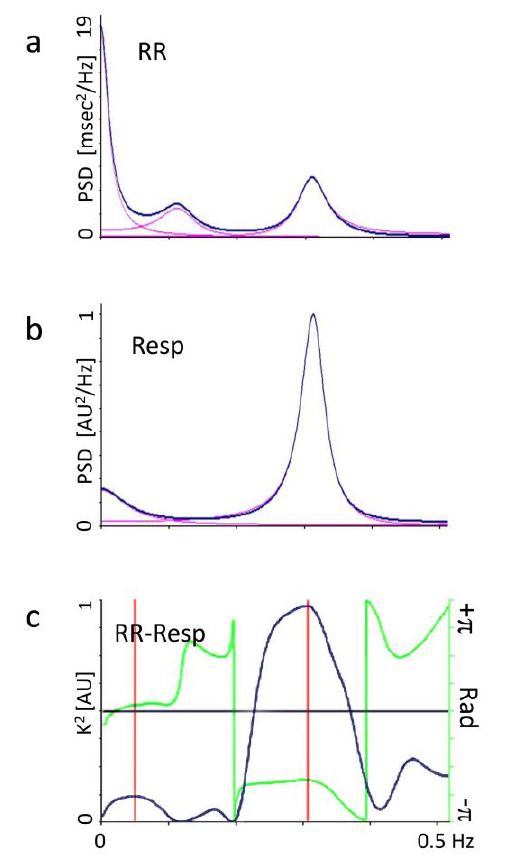
Figure 1. Panel a (labelled RR) depicts an example of an autospecrum (PSD) of RR interval variability obtained at rest on a study participant. The overall spectrum is drawn in blue, and as customary in healthy normal subjects, three major components are observed. They correspond to three individual spectral oscillations (indicated in red), that are recognized by the software tool. In normal conditions there is a component synchronous with respiration (denominated High Frequency, HF, about 0.25 Hz) and a second component at a Lower Frequency (LF, about 0.10 Hz). A third component around 0Hz corresponds to DC noise and very low frequency shifts of the RR interval signal (denominated usually VLF). Smaller noise components may also be present, usually below 5% of oscillatory power. Notice that ordinates should be multiplied by 1000. Panel b (labelled Resp) depicts an example of respiratory autospectrum. Notice that a single major component (at high, respiratory frequency) is observed typical of resting, physiological breathing. The Panel c (labelled RR-Resp) depicts in blue the coherence function (k2) between RR interval variability (i.e., tachogram) and respiration signal. In this optimal case it corresponds to almost 1. At any rate also smaller values, at least greater than 0.5 indicate, a significant exchange between RR interval and respiration; values smaller than 0.5 indicate non-significant coherence. In green is also depicted, for completeness, the Phase function (from − π to + π ). This example depicts the well known phenomenon of the tachycardia accompanying inspiration (in this example the phase di ff erence is about − 0.6 rad corresponding to about 120 ◦ ). Slow breathing (around 0.1 Hz) clouds the interpretation of RR interval autospectra. (see also 14, 18, 27).